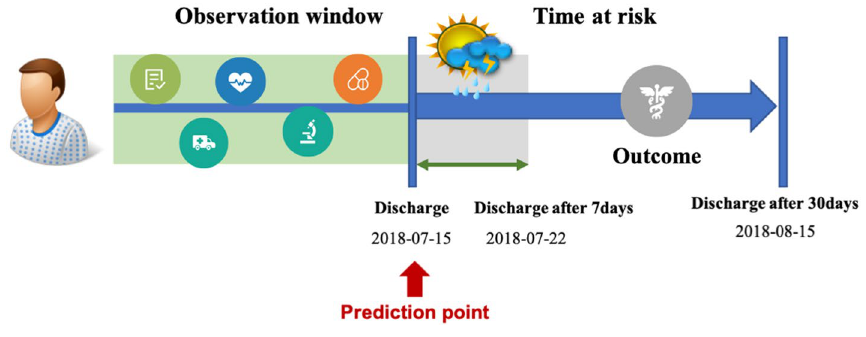
Figure 4. Prediction